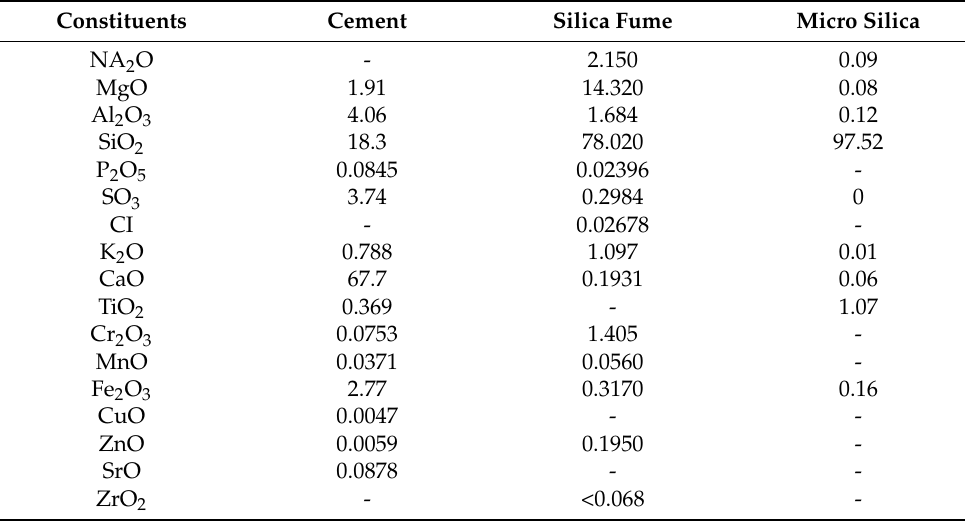
Table 2. Chemical compositions of materials (wt.%).